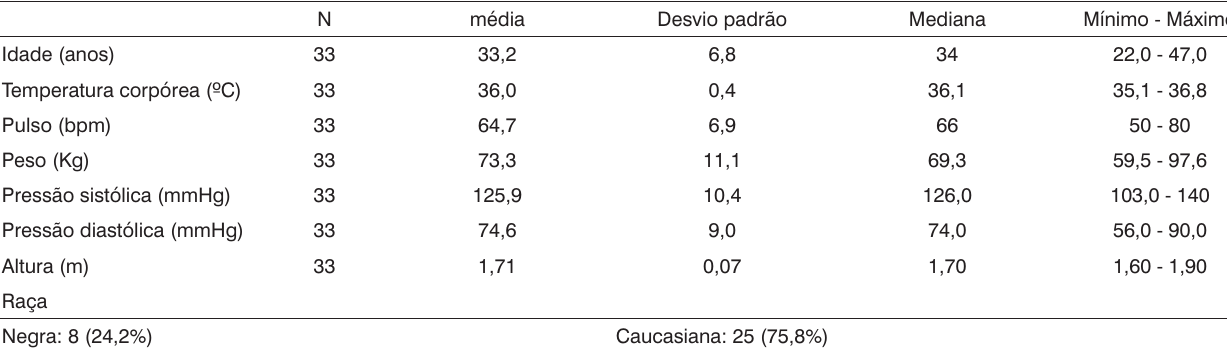
Tabela 1. Resultados encontrados na Avaliação Clínica (AC).